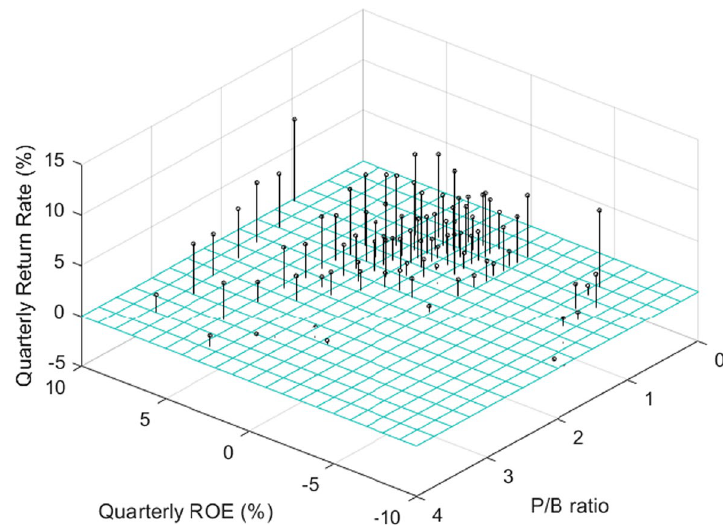
Fig. 34 3D pin chart of ROE (X), P/B (Y) in the t quarter, and the return rate in the t portfolio are formed (Z)